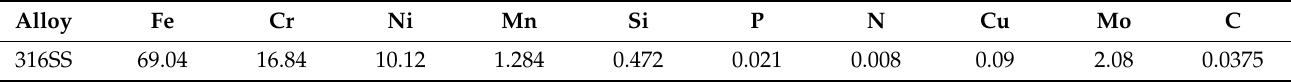
Table 2. Chemical compositions of 316SS